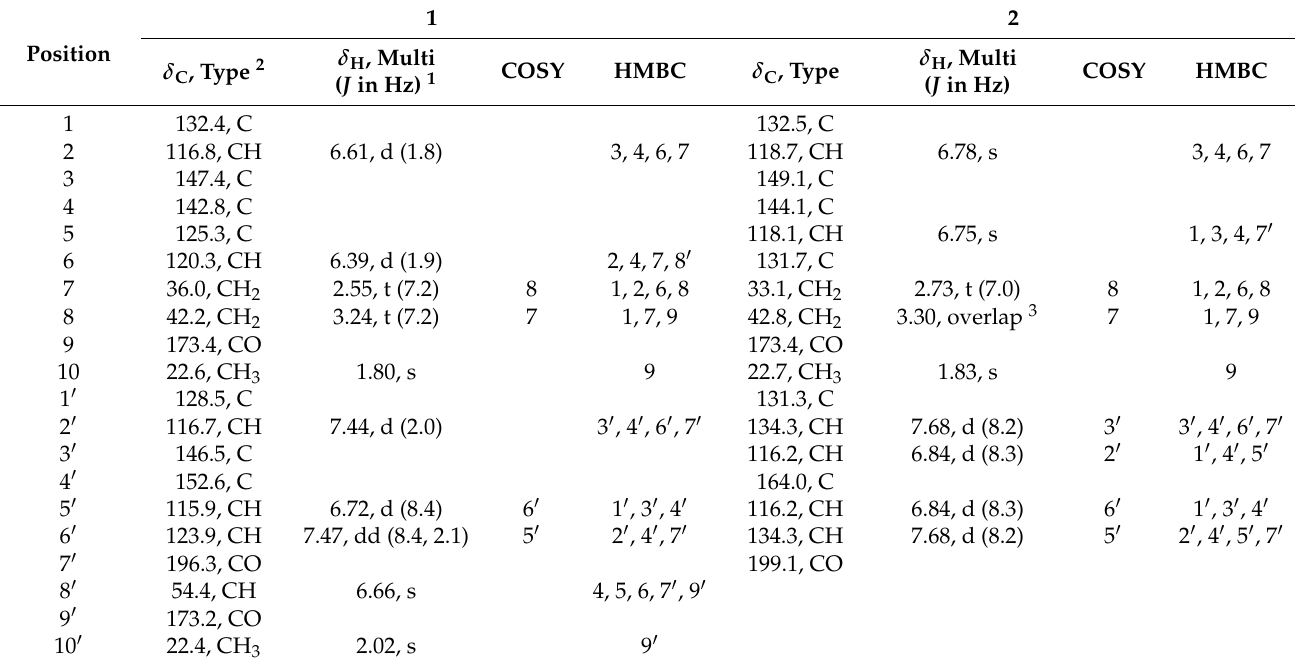
Table 1. 1D NMR ( 1 H and 13 C) and 2D NMR (HMBC and COSY) data for compounds 1 and 2 in CD 3